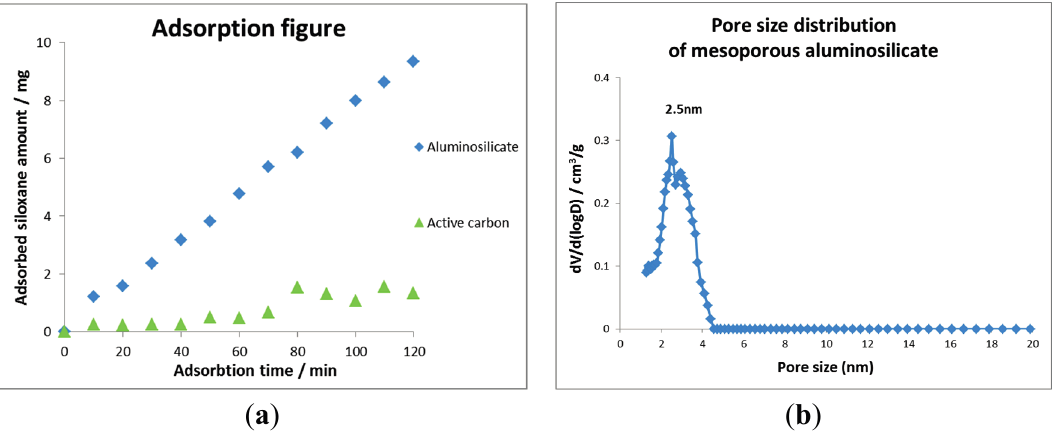
Figure 12. ( a ) Adsorption of siloxane on the adsorbents over time, UCT material compared to activated carbon; ( b ) Pore size distribution of mesoporous